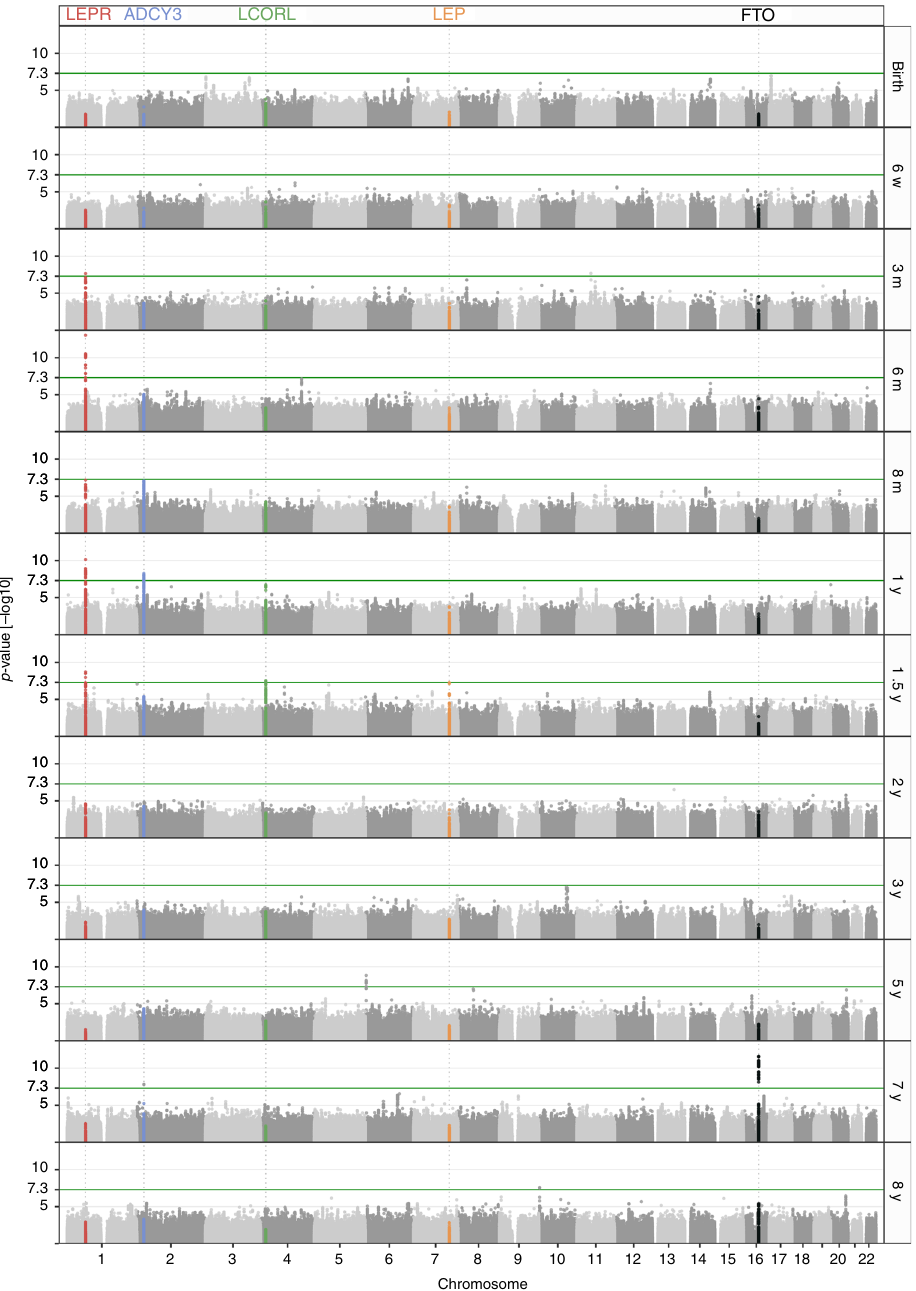
Fig. 2 Manhattan plots at all time points. Manhattan plots showing association results at birth, 6 weeks; 3, 6, and 8 months; and 1, 1.5, 2, 3, 5, 7, and 8 years of age in the discovery sample. LEPR , ADCY3 , LCORL , LEP , and FTO loci are highlighted in red, blue, green, orange, and black,